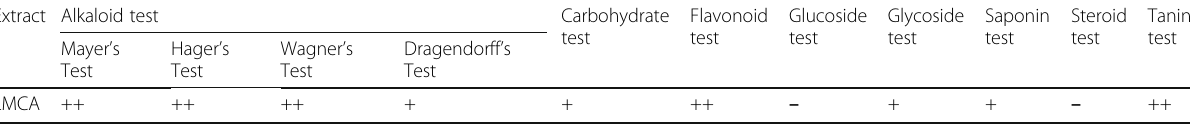
Table 1 Results of phytochemical screening of LMCA Extract Alkaloid